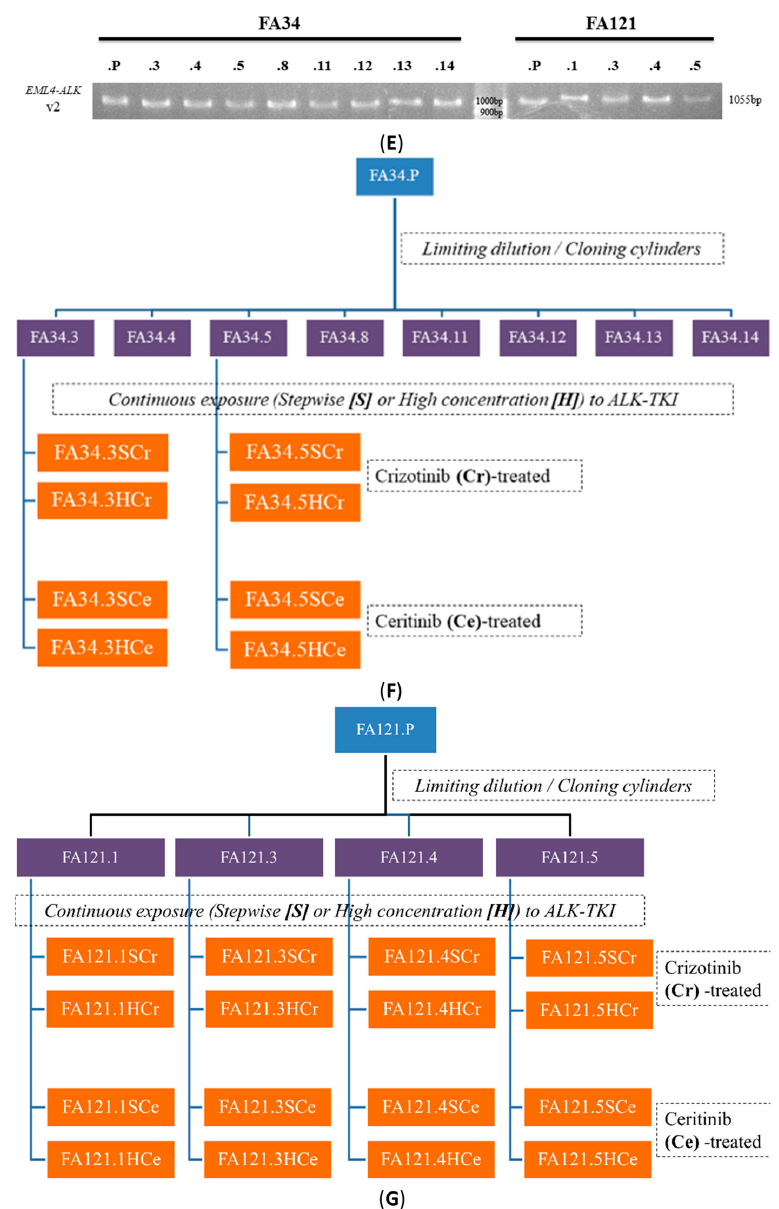
Figure 1. Characterization of the two echinoderm microtubule-associated protein-like 4 - anaplastic lymphoma kinase ( EML4-ALK) -translocated lung adenocarcinoma cell lines and their subclones. The morphology of the various subclones derived from two parental lines ( A ) FA34.P and its subclones, and ( B ) FA121.P and its subclones. Split of ALK gene in ( C ) FA34 and ( D ) FA121 parental lines and their subclones were validated by ALK-specific break-apart fluorescence in situ hybridization (FISH) probe (arrows). ( E ) EML4-ALK variant 2 was reconfirmed by reverse transcription-polymerase chain reaction (RT-PCR) in all FA34 and FA121 parental lines and their subclones. Generation of crizotinib- or ceritinib-resistant EML4-ALK lung adenocarcinoma cell lines ( F ) FA34 and ( G ) FA121. Crizotinib- (Cr) or ceritinib (Ce)-resistant subclones derived from prolonged stepwise (S) or high concentration (H) treatment on (A) FA34 subclones or (B) FA121 subclones.